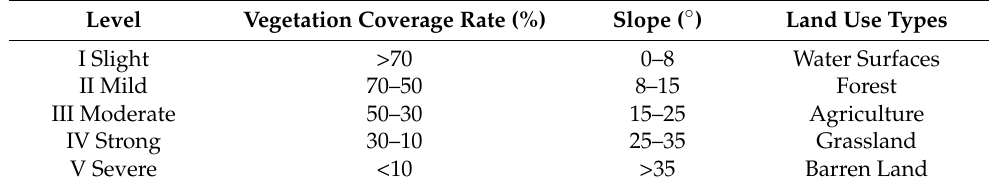
Table 2. Classification and grading standards of soil erosion in